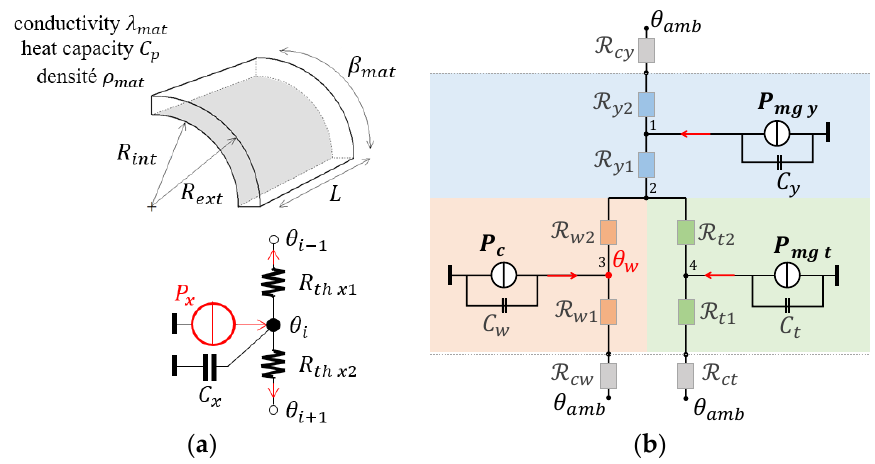
Figure 3. ( a ) Thermal equivalent circuit of a cylindrical element; ( b ) lumped parameter thermal model of PMSG.